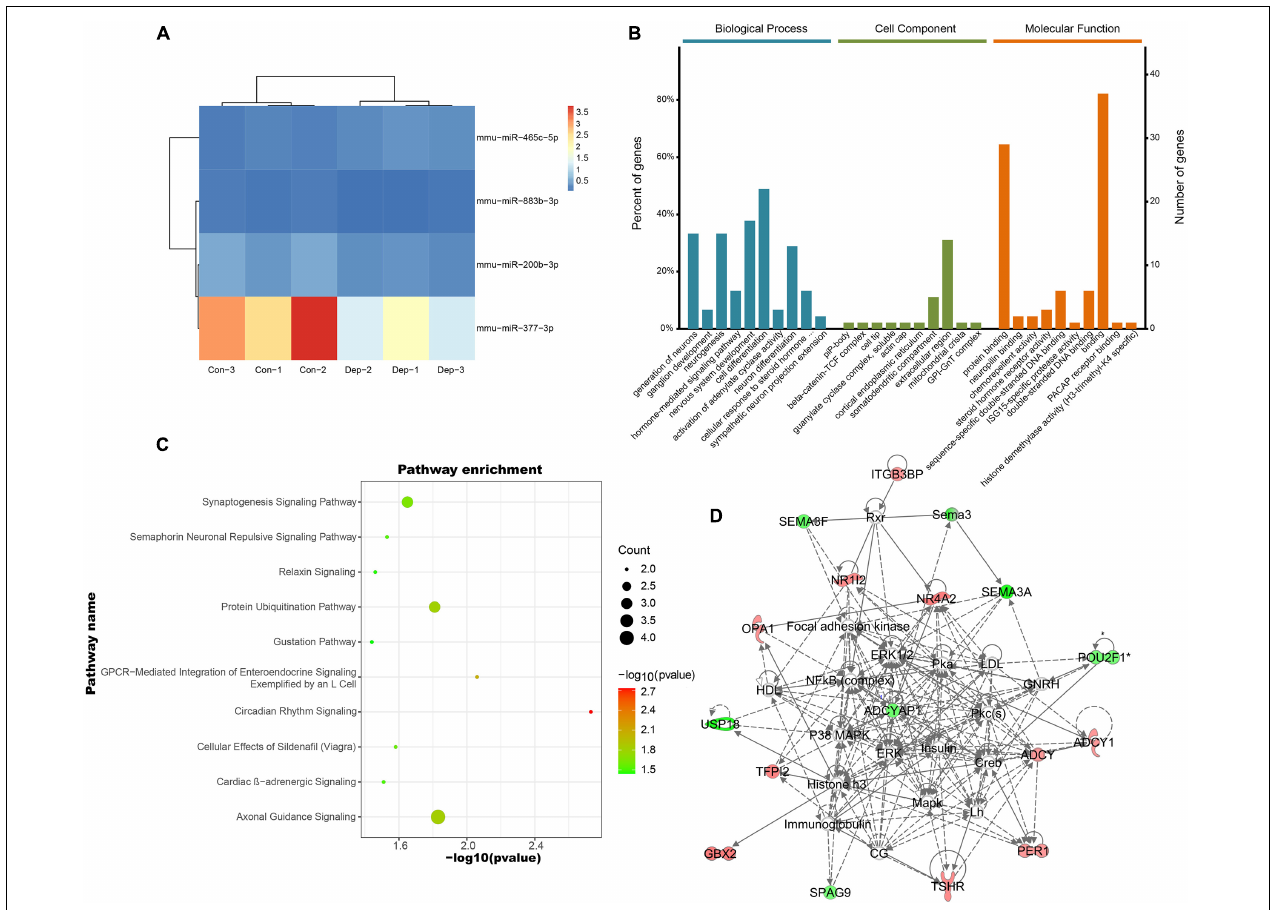
FIGURE 4 | Identification and functional analysis of differentially expressed miRNAs (DEMs) in gut microbiota-dysbiosis mice. (A) Hierarchical clustering of DEMs. (B) GO annotations of the intersected DEM targets. (C) Canonical pathway enrichment for the 47 intersected DEM targets analyzed using IPA software. (D) Functional network analysis for the 47 intersected DEM targets revealed by IPA